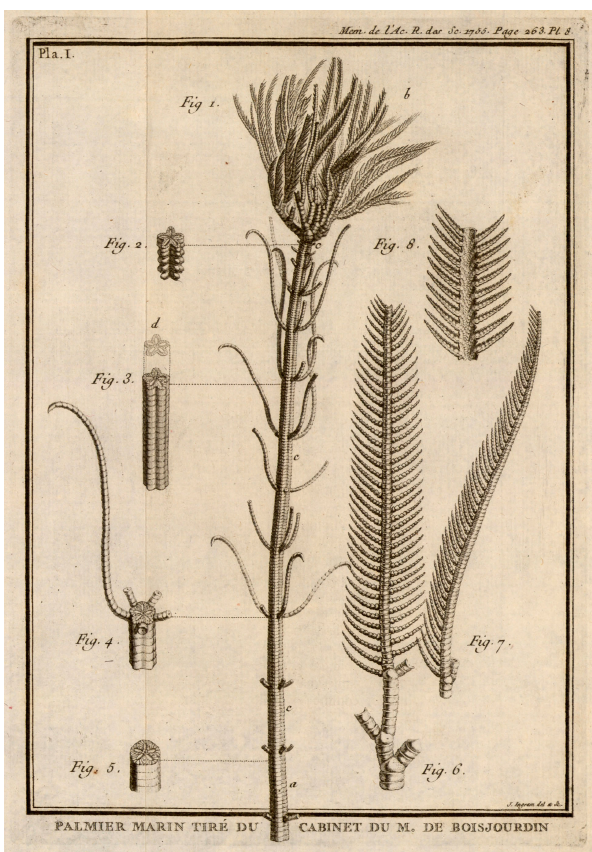
Figure 2. Cenocrinus asterius (Linné, 1767) (from Guettard, 1761, pl. 8; as “Palmier marin”). This was the first modern stalked crinoid that was described.